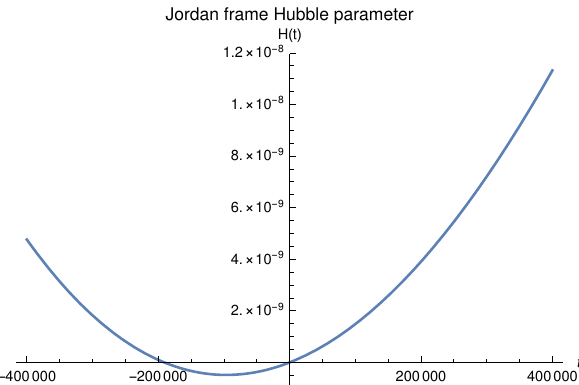
Figure 18. Time evolution of the Hubble parameter in the Jordan frame in vacuum background in exponential gravity with the initial conditions H ( 0 ) = 0, ˙ H ( 0 ) = 10 − 14 , ¨ H ( 0 ) = 10 − 19 .